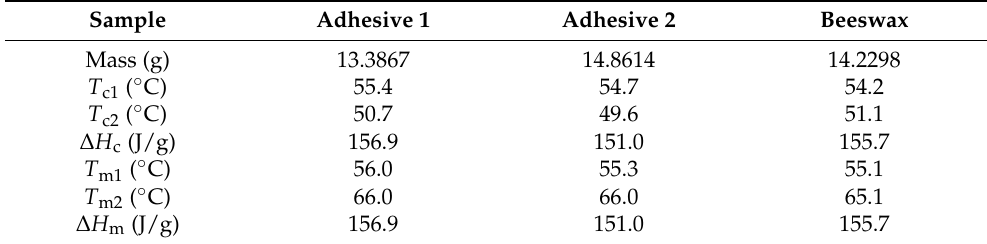
Table 4. Thermal properties of adhesives sampled from two places of the box and commercial